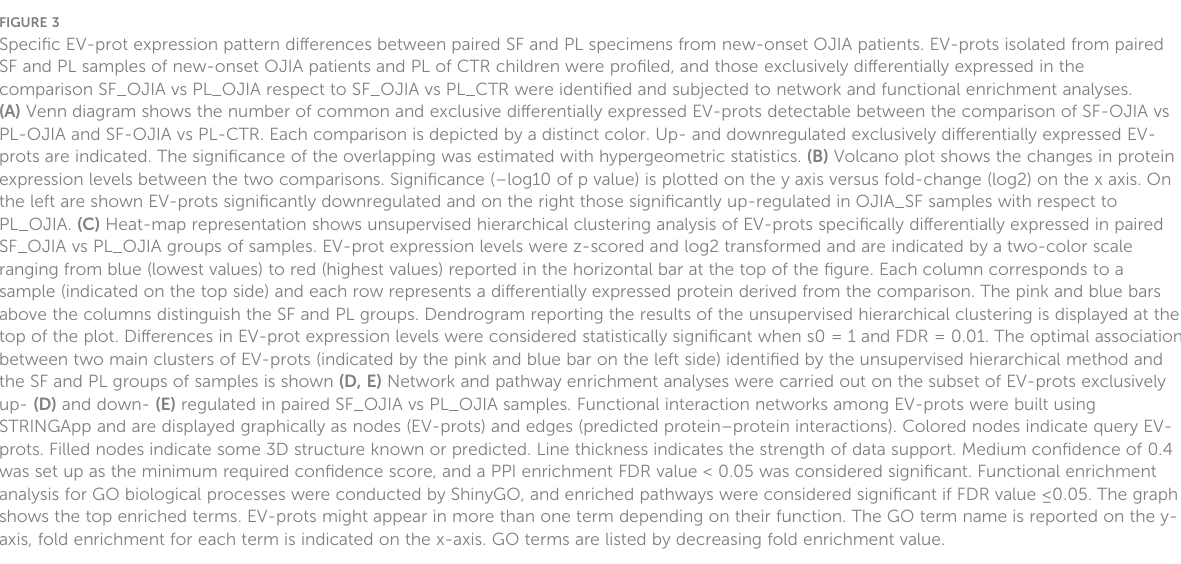
exclusively in the joints or in the circulation of OJIA patients and thus obtain further insights into the mechanisms of disease development. P value ≤ 0.0001 was considered statistically signi fi cant. This analysis identi fi ed subsets of 33 and 28 EV-prots exclusively expressed in SF or PL groups, respectively (p- value<0.0001, Table 3). Heatmap visualization of EV-prot expression values showed a clear association of signi fi cant EV- prots and SF or PL samples (Figure 4A), visually con fi rming the results of the binomial test. Network analysis established a signi fi cant connection among some identi fi ed EV-prots (PPI p- value<0.05, Figures 4B, C). Pathway analysis of these proteins showed the signi fi cant enrichment (FDR ≤ 0.05) of 98 GO biological (41 related to EV-prots expressed in SF and 57 in PL)